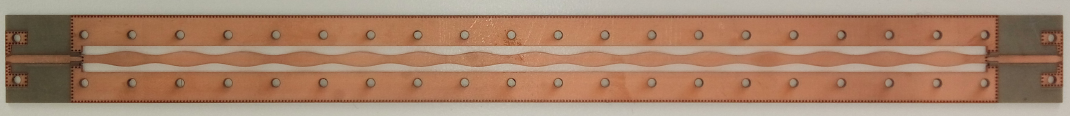
Figure 8. Manufactured prototype of the ESICL continuous profile filter.